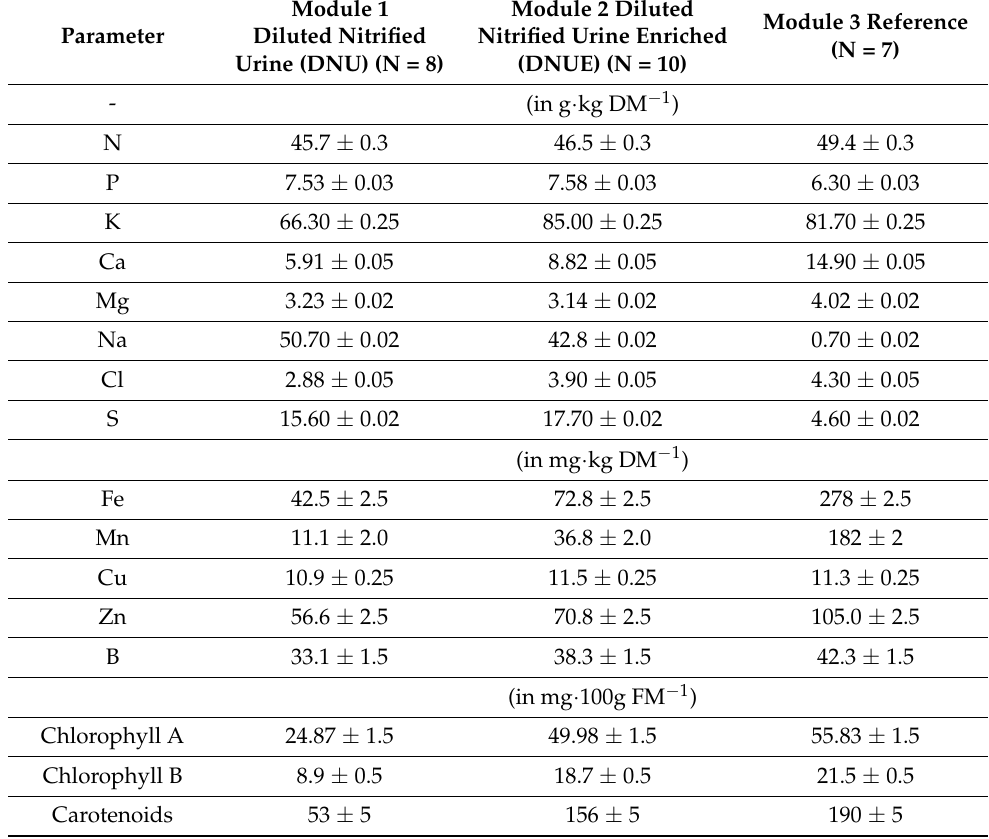
Table 4. Content of macro- and microelements and photosynthetic pigment content in leaves averaged sample in the three treatments (measured value ± measurement error). DM—dry mass, FM—fresh mass. N—number of